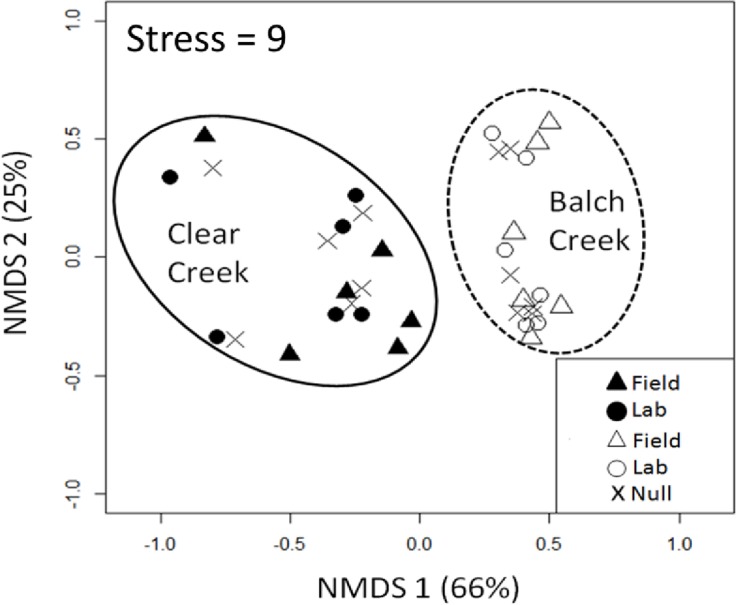
Ordinations of invertebrate assemblage at both Balch Creek (n = 6) and Clear Creeks (n = 6).Ordinations for the Field method (triangles, n = 6) and Lab method (circles, n = 6) are shown with the corresponding Null model assemblage (X, n = 6 at each creek). Symbols represent an individual sample collected at Clear Creek (closed symbols) and at Balch Creek (open symbols). Variance explained by each axis shown in the axis label.